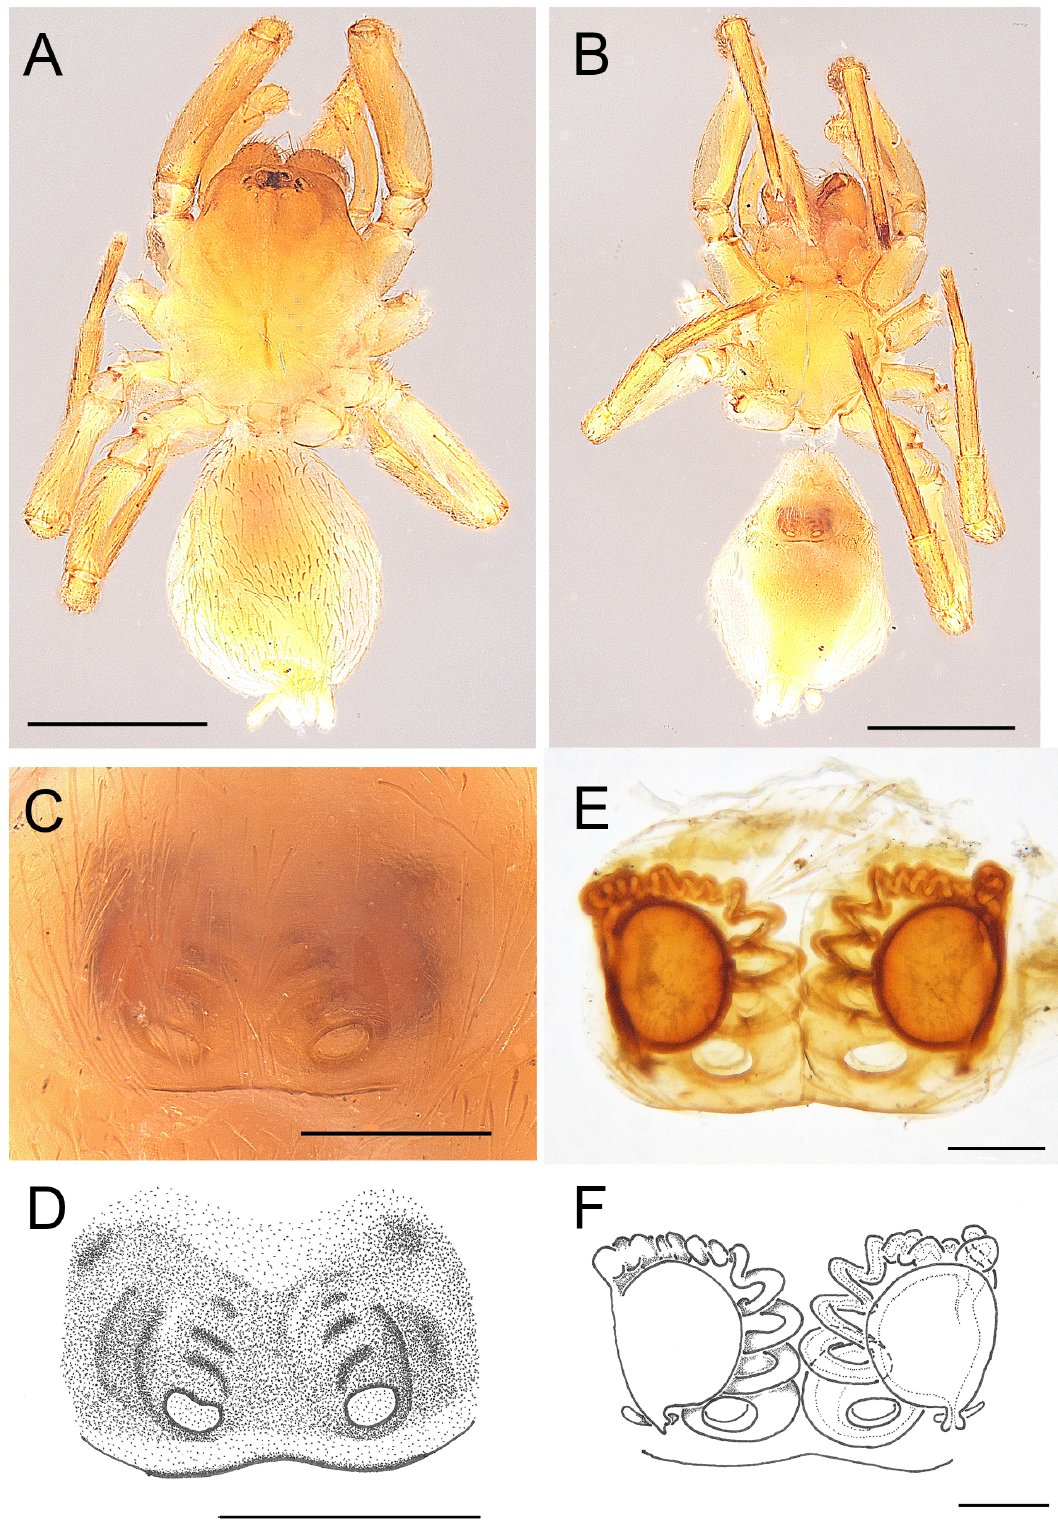
Fig. 27. Andromma helix sp. nov., ♀, holotype (BE_RMCA_ARA.Ara 152957). A . Habitus, dorsal view. B . Same, ventral view. C–D . Epigyne, ventral view. E–F . Same cleared, dorsal view. Scale bars: A–B = 1 mm; C–D = 0.2 mm; E–F = 0.1